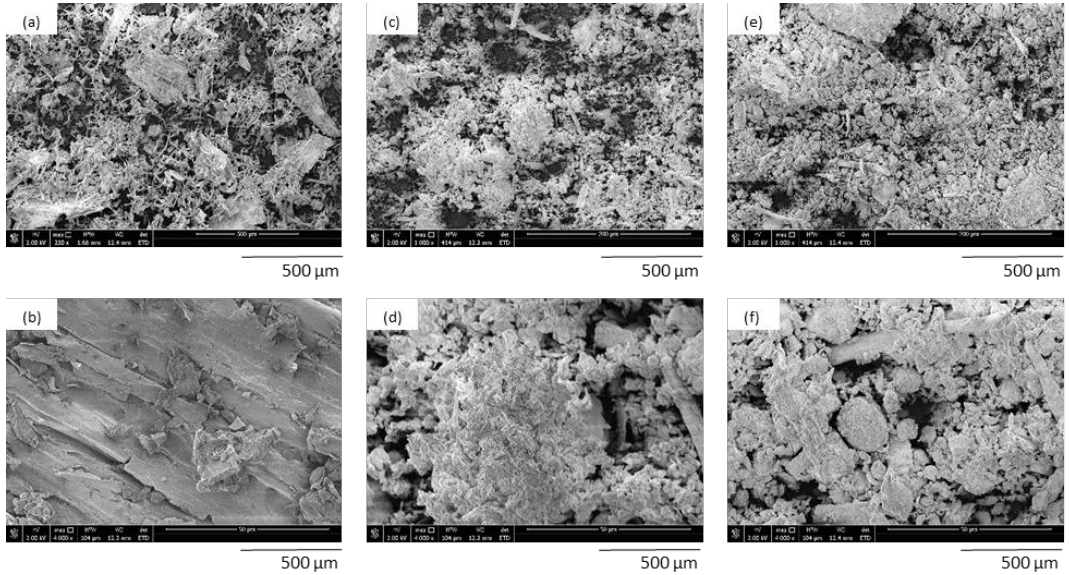
Figure 3. SEM images of lavender fillers: ( a , b ) non-functionalized lavender, ( c , d ) lavender functionalized with kaolinite, ( e , f ) lavender functionalized with hydroxyapatite. Adapted from Ref. [13]. Considering the antibacterial and antioxidative properties of lavender [57,58], kaolin-